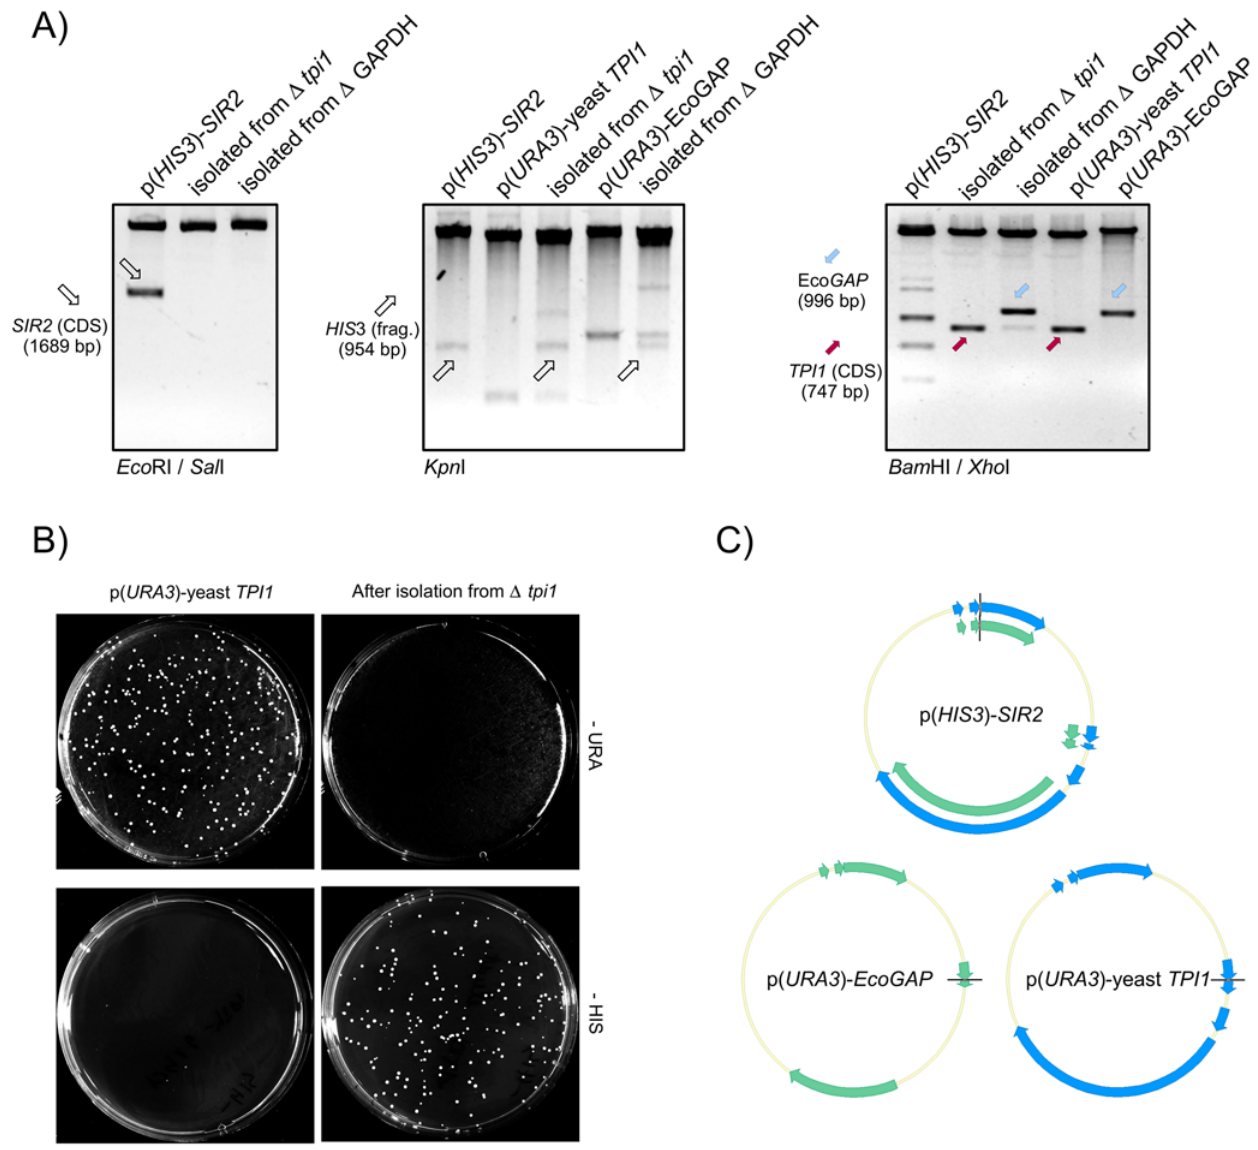
Figure 2. Deregulation of the glycolysis/Sir2 equilibrium causes plasmid recombination. (A) Plasmids isolated from 5 9 FOA counter- selected, Sir2-overexpressing D tpi1 and D tdh1 D tdh2 D tdh3 ( D GAPDH) cells were amplified in E. coli and digested with Eco RI/ Sal I (left panel), Kpn I (middle panel) or Bam HI/ Xho I (right panel) and compared with equivalently-treated p( HIS3 )- SIR2 , p( URA3 )-yeast TPI1 , or p( URA3 )-EcoGAP, respectively. (B) p( URA3 )- TPI1 and the Tpi-encoding plasmid isolated from 5 9 FOA counter-selected, Sir2-overexpressing D tpi1 yeast were transformed into BY4741, plated on SC -HIS and SC -URA media and incubated at 30 u C. (C) Plasmid sequences of p( URA3 )- Eco GAP and p( URA3 )-yeast Tpi1 were aligned to the sequence of p( HIS3 )- SIR2 . Identical regions between p( URA3 )- Eco GAP and p( HIS3 )- SIR2 are highlighted in green, regions shared between p( URA3 )- yeast TPI1 and p( HIS3 )- SIR2 in blue.